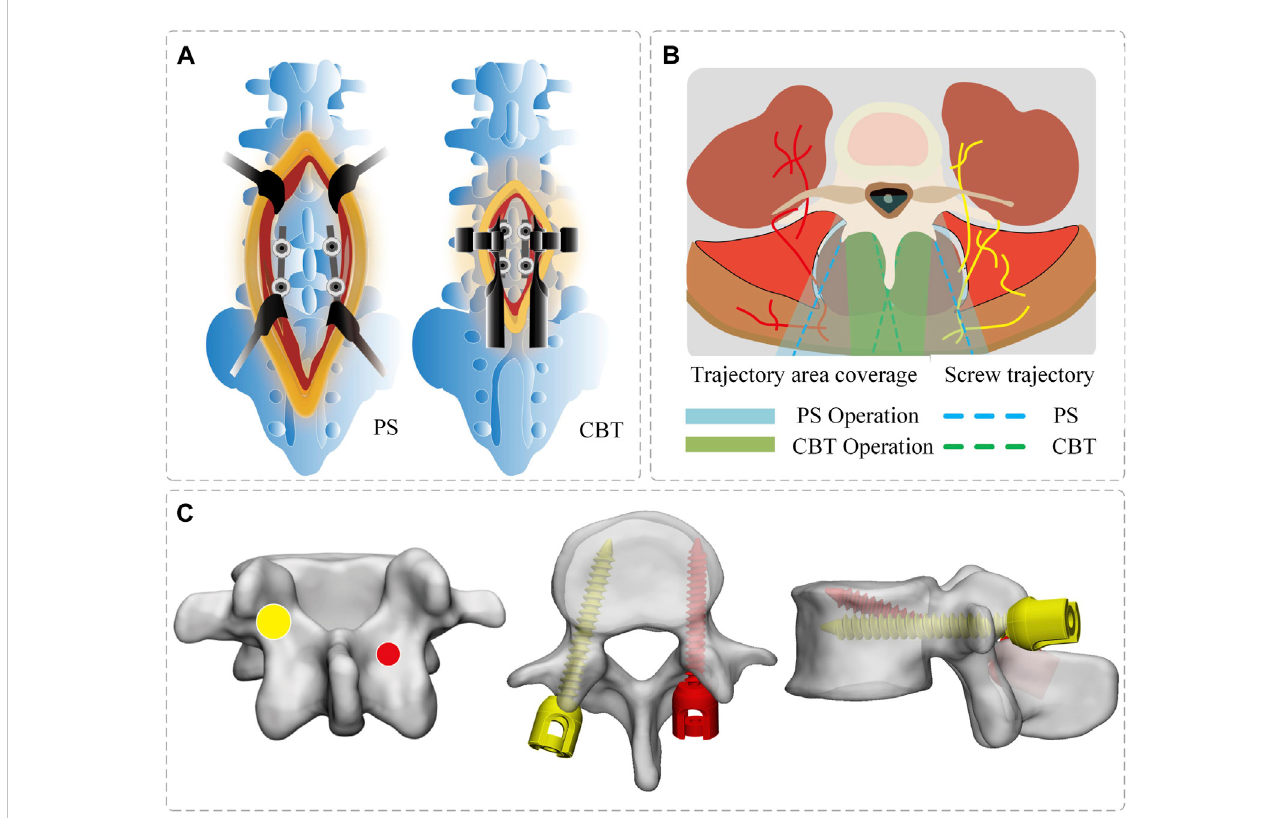
FIGURE 1 Schematic diagram of screw placement. (A) Surgical incision in PS/CBT group. (B) PS/CBT trajectory area coverage. (C) Position of the entry point and screw trajectory (PS — yellow, CBT — red). The screw entry point PS is located at the apex of the herringbone crest and CBT is located at the isthmus of the vertebral